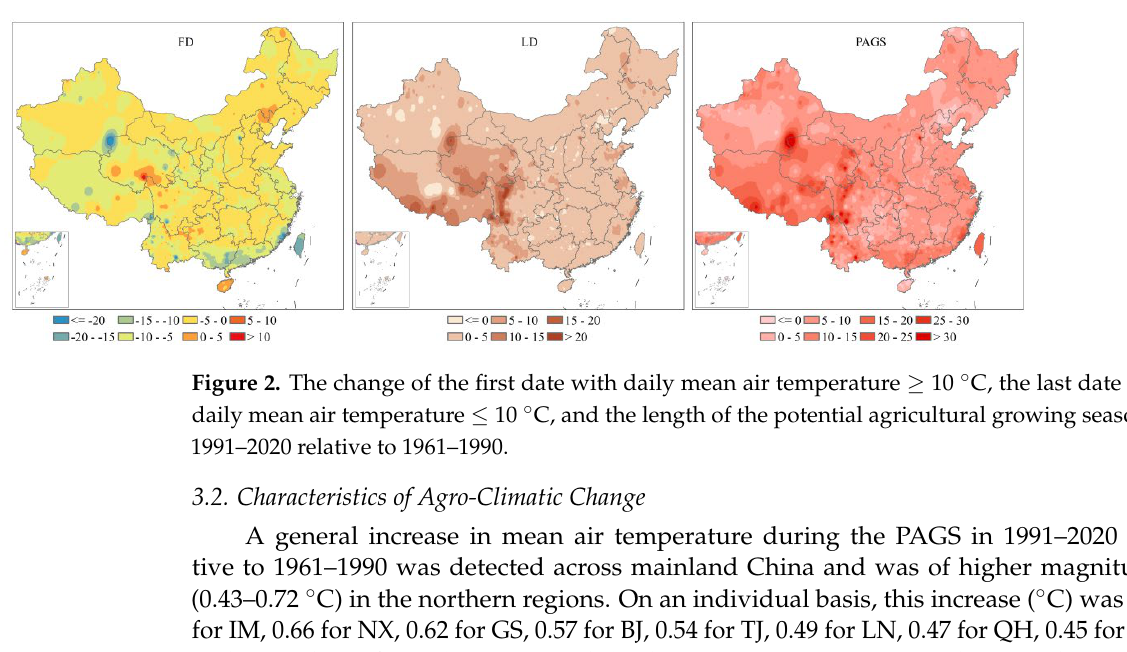
Figure 4. Probability density function (PDF) patterns of the mean air temperature during the poten- tial agricultural growing season in 1961–1990 and 1991–2020 (blue and red curve represents the PDF value in 1961–1990 and 1991–2020, respectively; blue dotted line and red dotted line represents the mean magnitude of mean air temperature in 1991 – 2020).